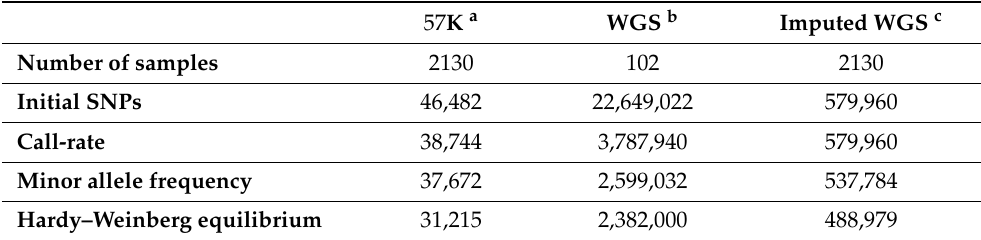
Table 1. Quality control results of genotyping of 57K SNP panel, whole genome sequence (WGS) and Imputed WGS data for the rainbow trout population.